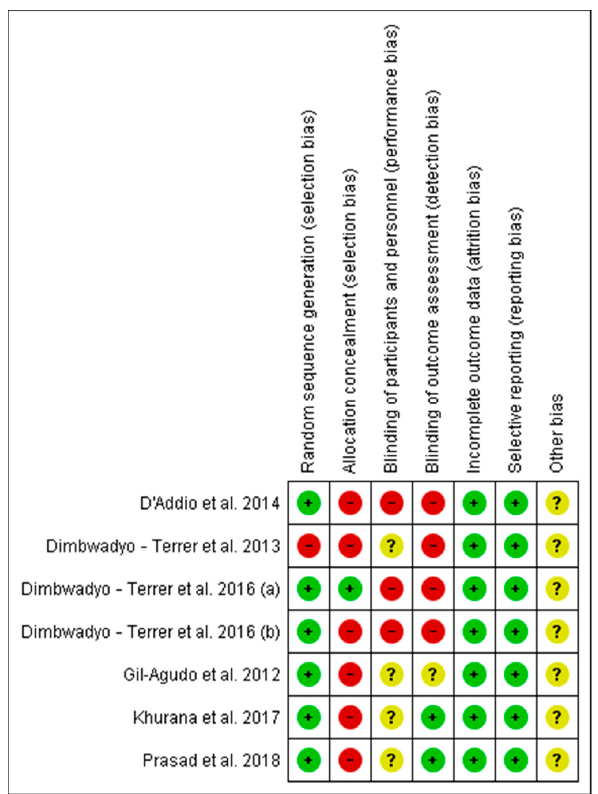
Figure 2. Risk of bias of the studies included in the systematic review. J. Clin. Med. 2020 , 9 , x FOR PEER REVIEW